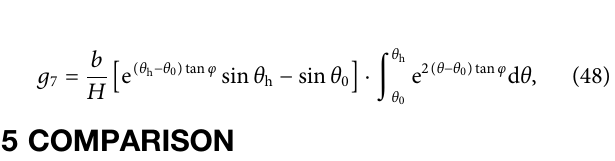
Frontiers in Earth Science |